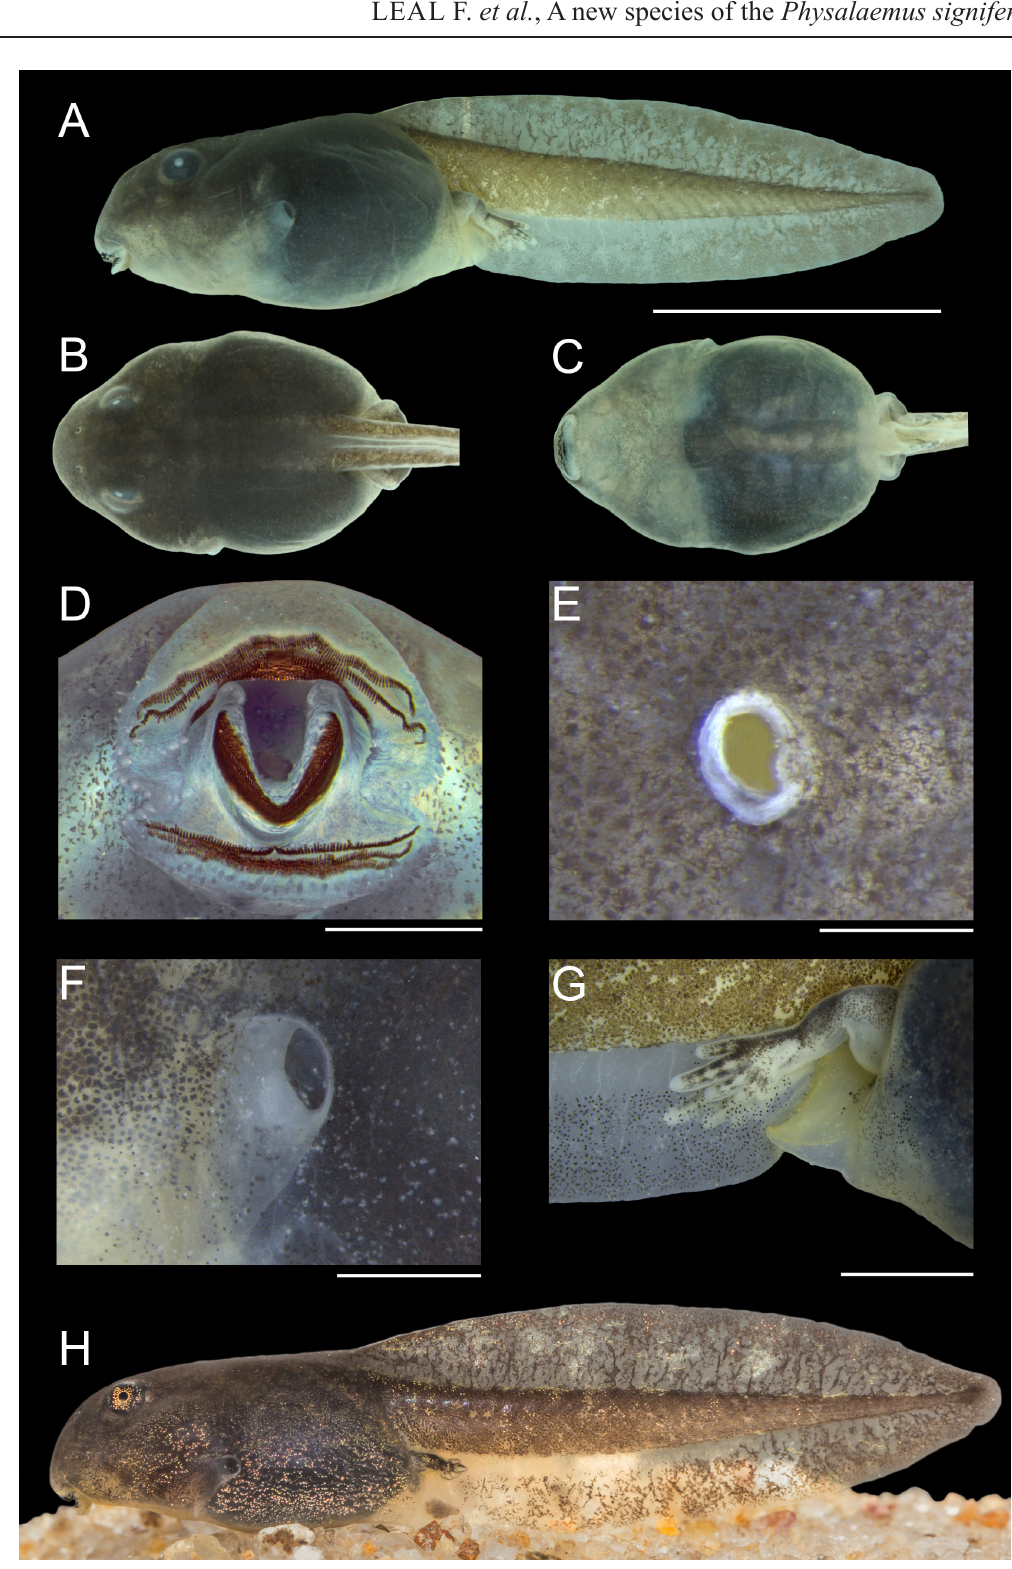
Fig. 6. Tadpole of Physalaemus araxa sp. nov. at stage 37 (ZUEC-AMP 24214). A . Lateral view. B . Dorsal view. C . Ventral view. D . Oral disc completely opened. E . Details of the right nostril in frontal view. F . Spiracle in lateral view. G . Vent tube in lateral view. H . Tadpole of Physalaemus araxa sp. nov. in life (photo not to scale). Scale bars: A–C, F–G = 10 mm; D = 1 mm; E = 0.5